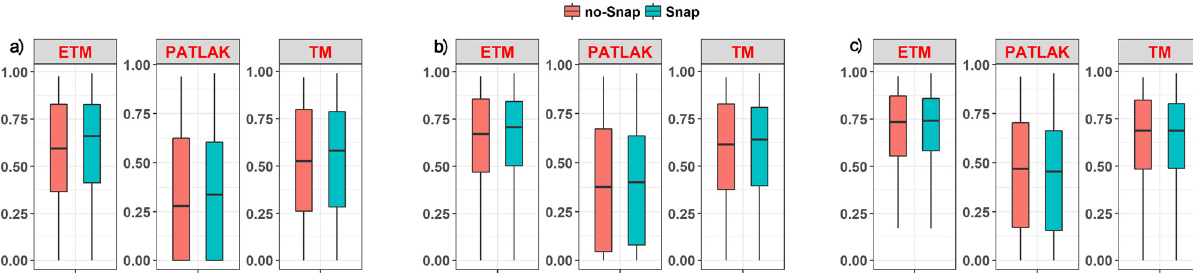
Figure 3: Adj - R 2 boxplots for di ff erent values of adj - R 2 thresholding: ( a ) 0.2 threshold, ( b ) 0.3 threshold, and ( c ) 0.4 threshold for NoSnap ( red ) and Snap ( green ) protocols.